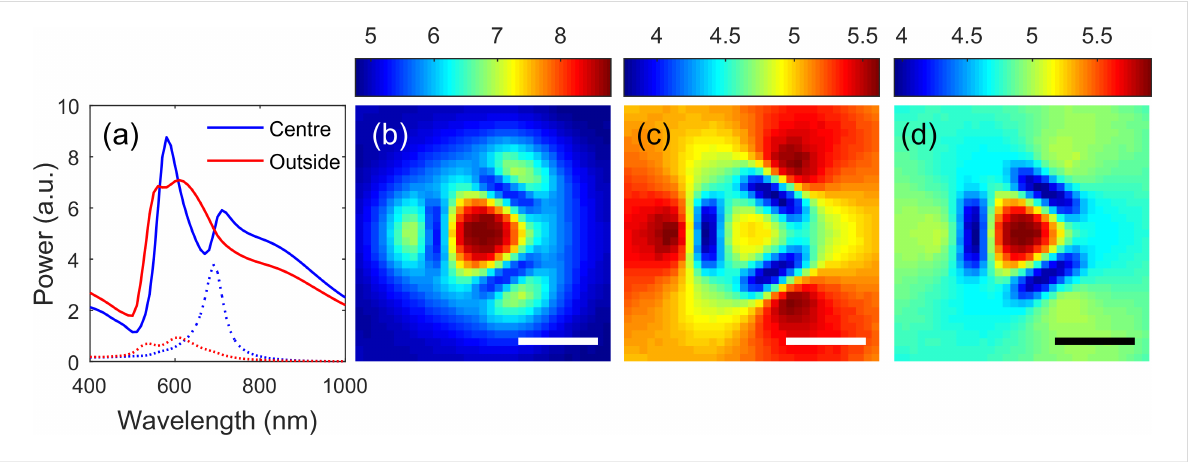
Figure 4: Simulated power radiated by a vertically oriented point dipole located 30 nm above a 100 nm thick gold film with three slots arranged in a triangular arrangement with length 100 nm and width 40 nm and separation of 60 nm. The spectra reflected from (solid curves) and transmitted through (dashed curves) the surface for dipoles located above the centre of the configuration and 5 nm outside the outer edge of one of the slots. The reflected power as a function of transverse dipole position is shown at wavelengths of (b) 580 nm, (c) 690 nm and (d) 710 nm. Scale bar is 100